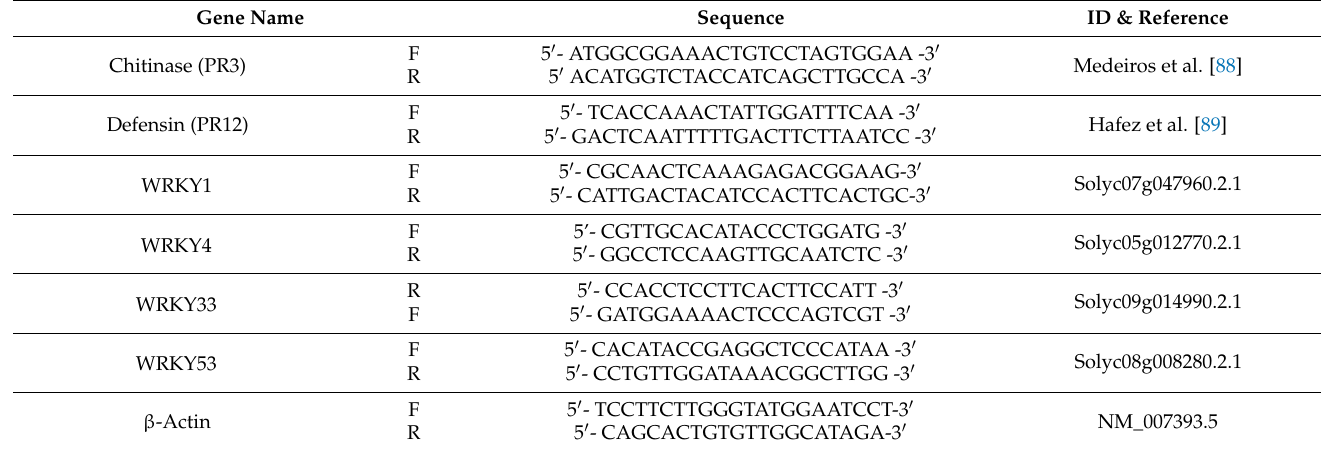
Table 4. Sequences of primers used in qRT-PCR analysis.